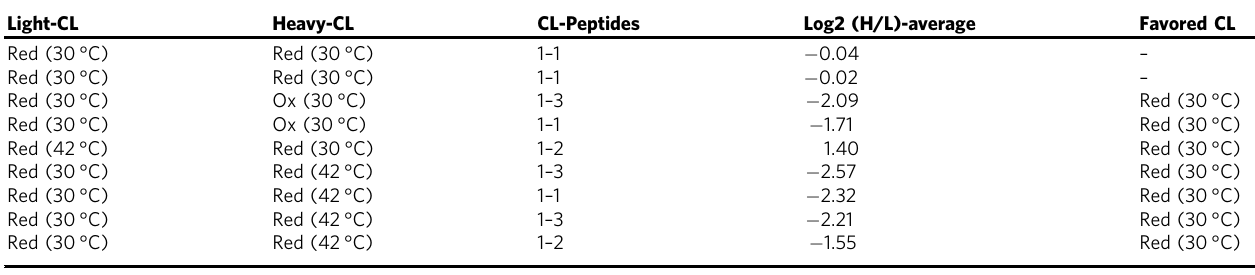
Table 2 Quantitative cross-linking (qCL) of mTXNPx red and mTXNPx ox using